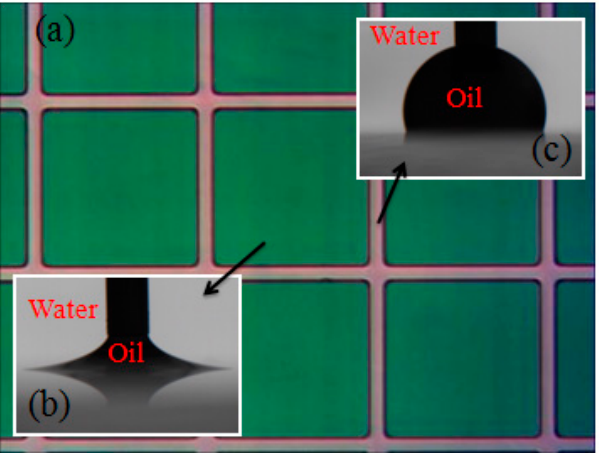
Figure 4. ( a ) Patterned electrofluidic arrays and ( b ) corresponding receding water contact angles of FP and ( c ) photoresist pixel wall materials. The syringe needle for oil dosing is also pictured.